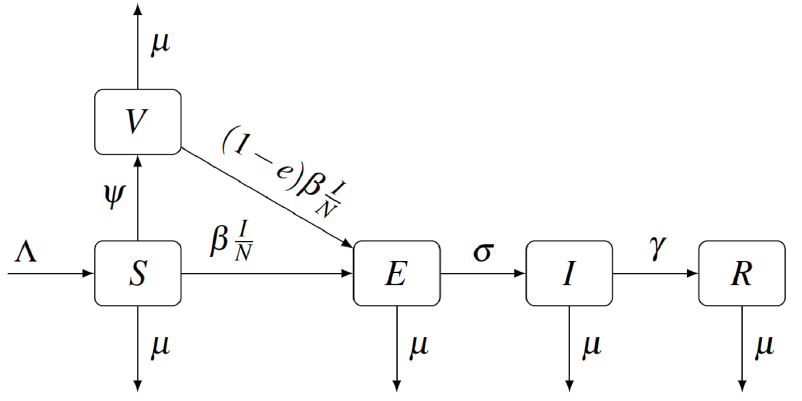
Fig 1. Scheme of the SVEIR model for MPX.